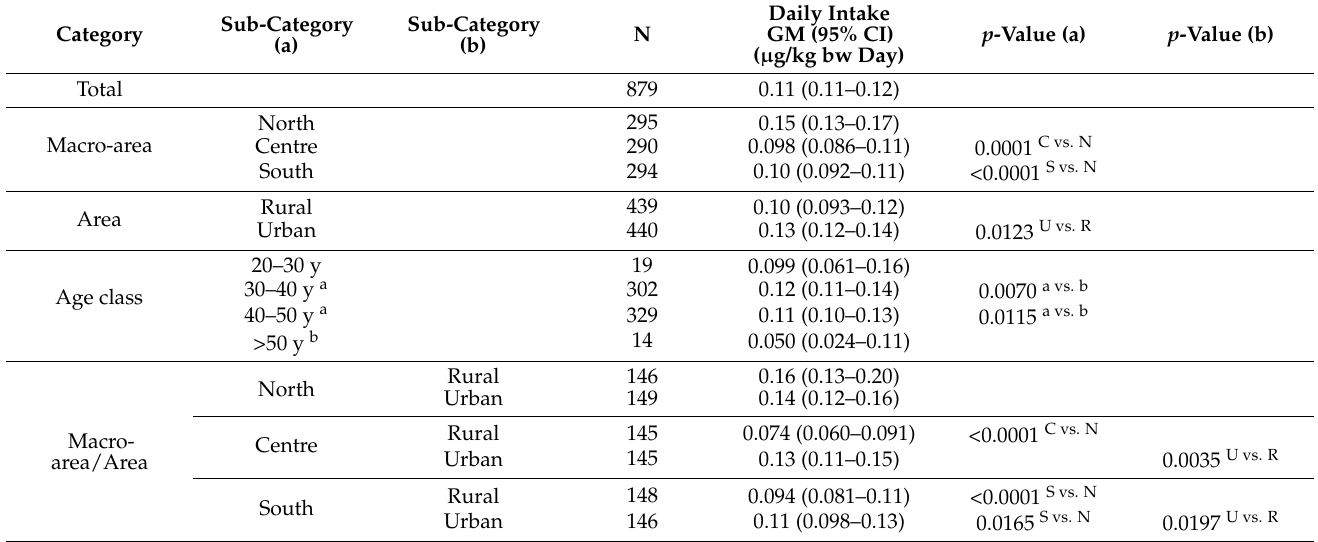
Table 6. Estimated daily intake ( µ g/kg bw per day) of BPA in Italian women (N = 879) according to residing areas and age.